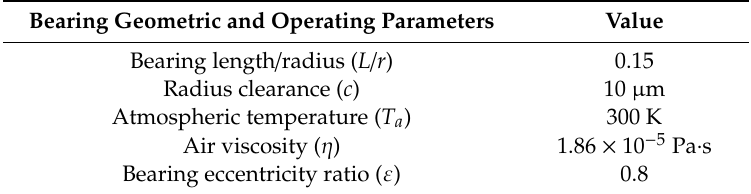
Table 1. Geometric and operating parameters of the bearing in Lee Y-B’s article. Bearing Geometric and Operating Parameters